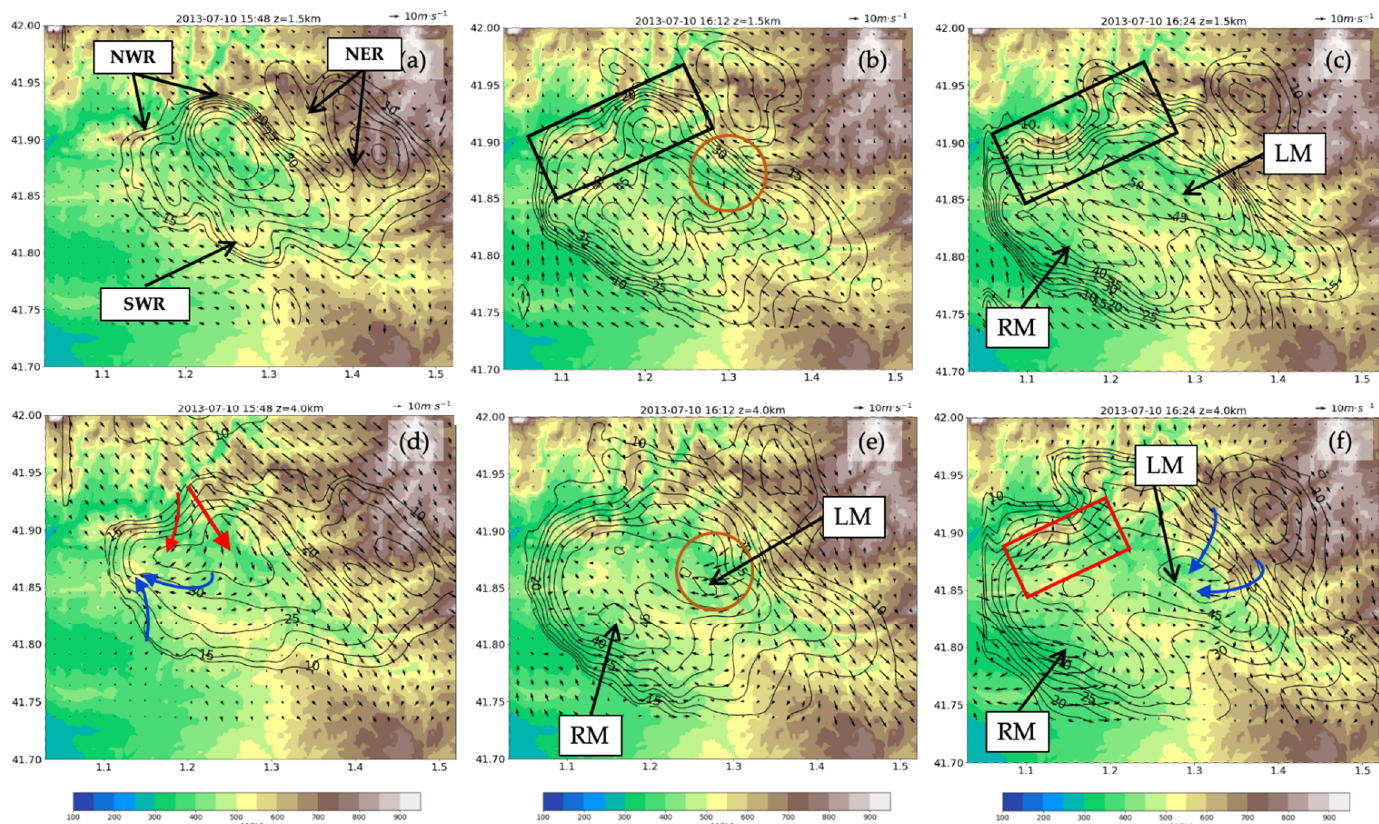
Figure 13. SAMURAI retrievals over topography for the splitting case on 10 July 2013 at Z = 1.5 km (upper row), and Z = 4 km (lower row). Reflectivity (dBZ) in contour lines (labeled every 5 dBZ) and storm-relative horizontal wind field (m · s − 1 ) (with black arrows) at ( a – d ) 15:48 UTC, ( b – e ) 16:12 UTC, and ( c – f ) 16:24 UTC. NWR, NER, and SWR indicate the northwest, northeast, and southwest ridges, respectively. Black and red frames indicate regions with winds impinging against the NWR ridges, and the region with wind difluence at mid-levels, respectively. Thick blue and red arrows indicate areas with converging and diverging winds, respectively. Orange circles indicate the closed circulation for the left mover supercell. Finally, LM and RM indicate the left- and right-mover supercells.